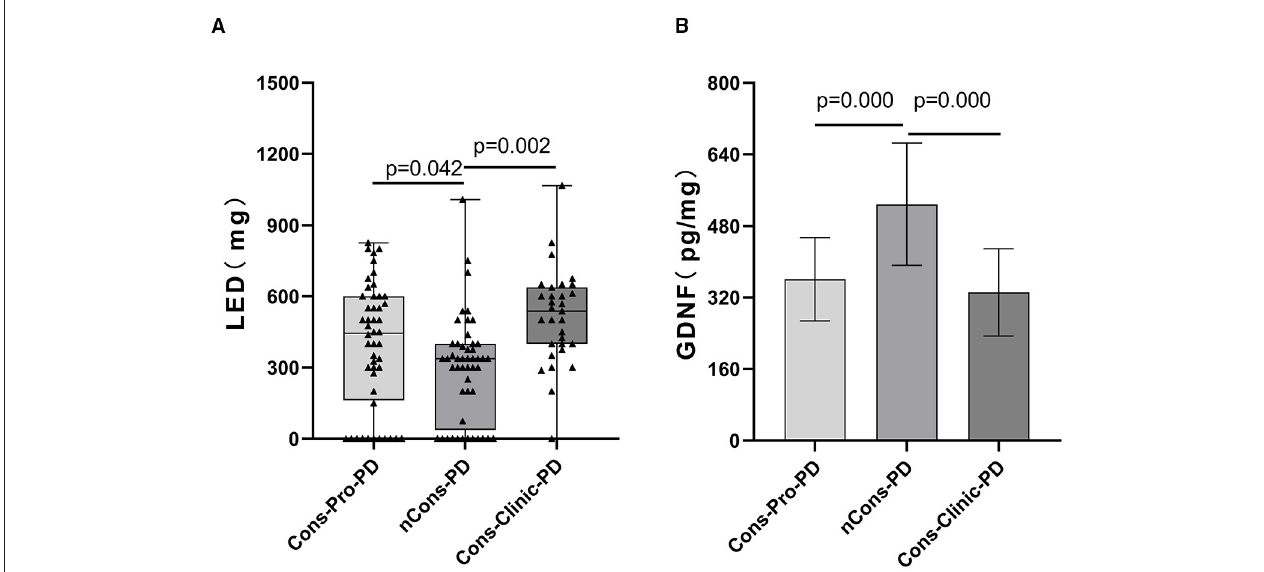
FIGURE 5 | (A) Depicts a pairwise analysis of the three groups’ median LEDs (mg). The median LEDs (mg) of the nCons-PD group was 337.5mg (QR 37.5–400), which was lower than the Cons-Pro-PD group (M 443.75mg, QR 162.5–600, p = 0.042) and the Cons-Clinic-PD group (M 537.5mg, QR 400–637.5, p = 0.000), with no statistically relevant difference between the Cons-Pro-PD and Cons-Clinic-PD groups ( p > 0.05). (B) Shows that the mean GDNF levels of the nCons-PD group were 528.44 pg/ml (SD 136.87), higher than the Cons-Pro-PD group 360.72 pg/ml (SD 93.18, p = 0.000), and the Cons-Clinic-PD group 331.36 pg/ml (SD 97.737, p = 0.000), with no statistically relevant variations found between the Cons-Pro-PD and Cons-Clinic-PD. TABLE 3 | Binary logistic regression between PD with constipation and PD with no constipation cohort. Variables in the Equation B S.E. Wald df Sig. Exp (B) 95% C.I. for EXP (B) Lower Upper − 0.45 0.145 9.691 0.002 0.48